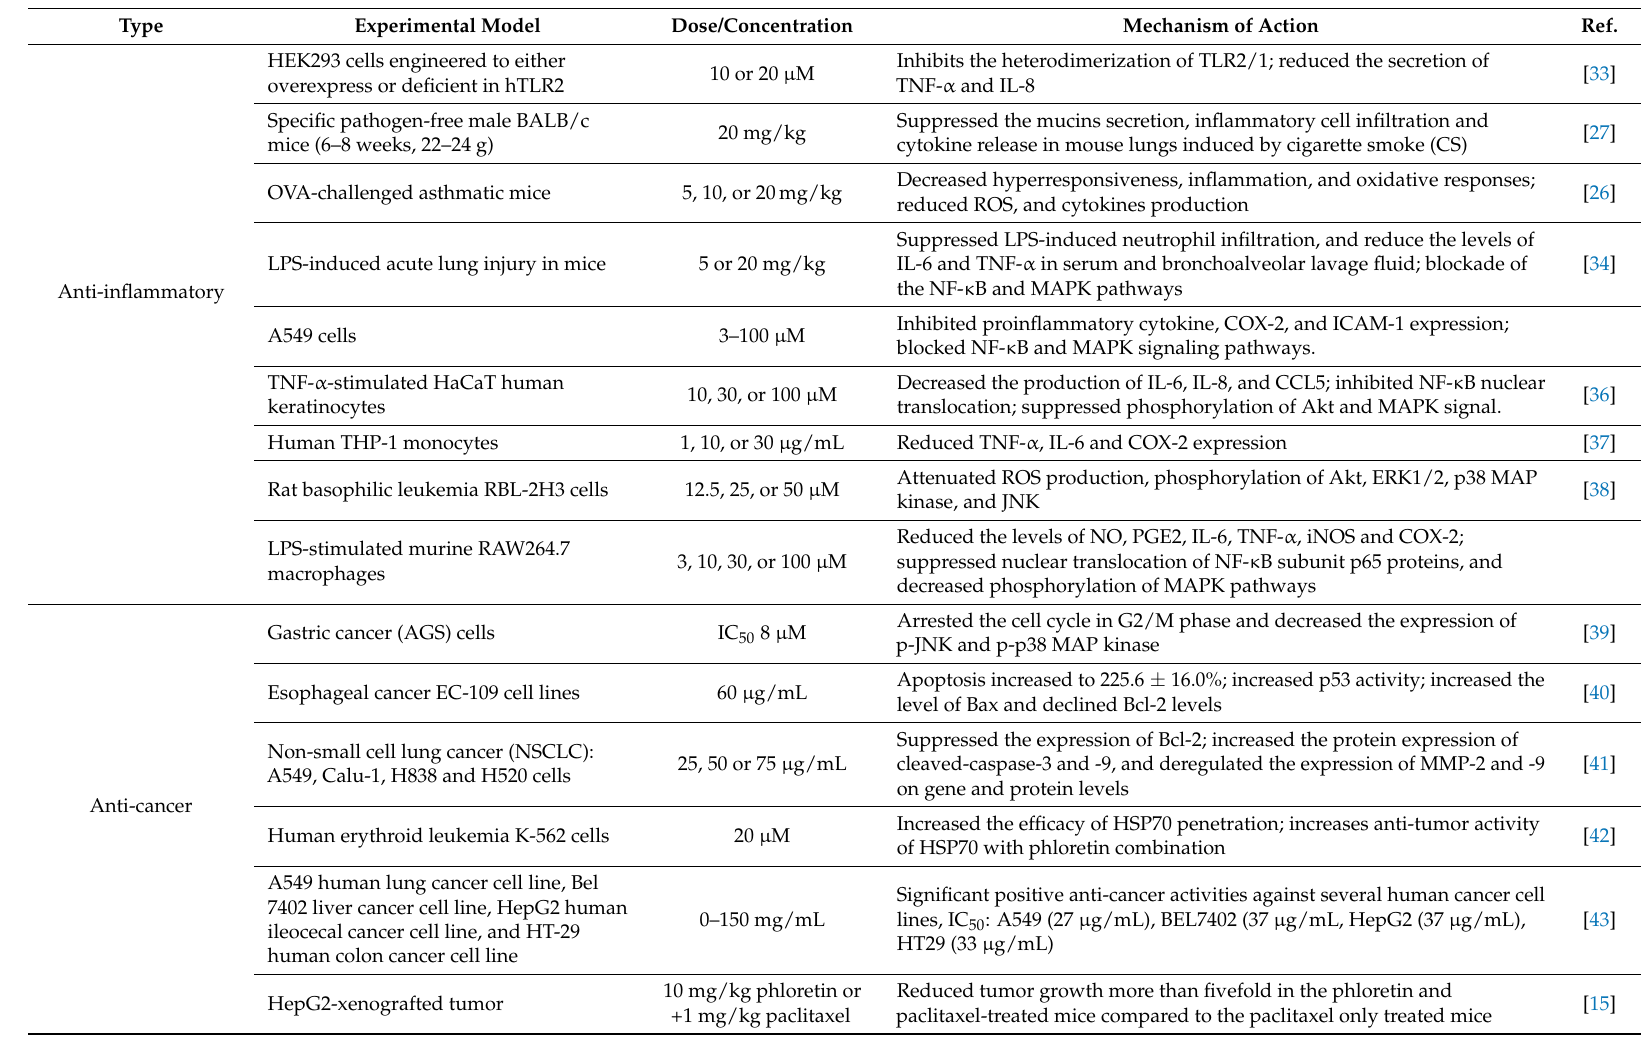
Table 1. Anti-inflammatory and anti-cancer activities of